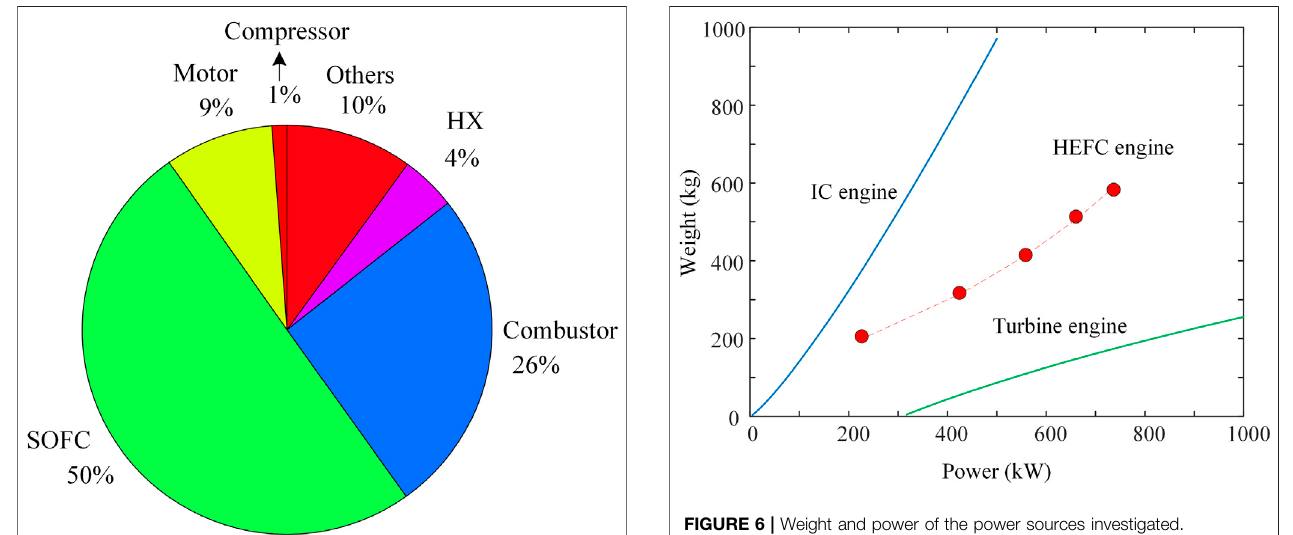
FIGURE 6 | Weight and power of the power sources